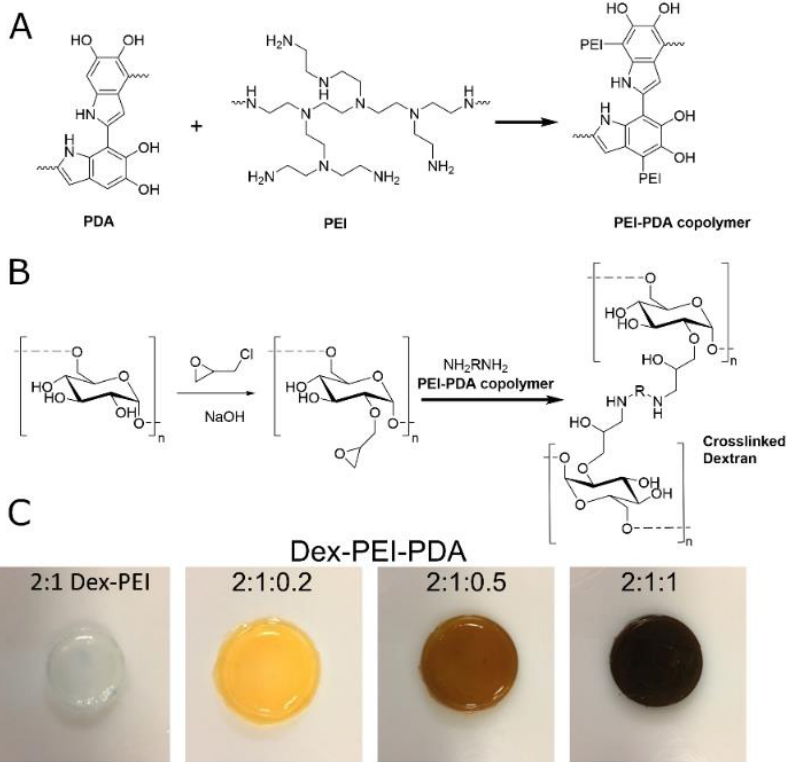
Figure 1. ( A ) Polyethylene imine-polydopamine (PEI-PDA) copolymer synthesis, ( B ) dex-PEI-PDA (dextran-polyethylene imine-polydopamine) hydrogel synthesis, ( C ) dex-PEI-PDA representative hydrogels with feed ratios of dextran:PEI:dopamine ranged 2:1:1–2:1:0.2.